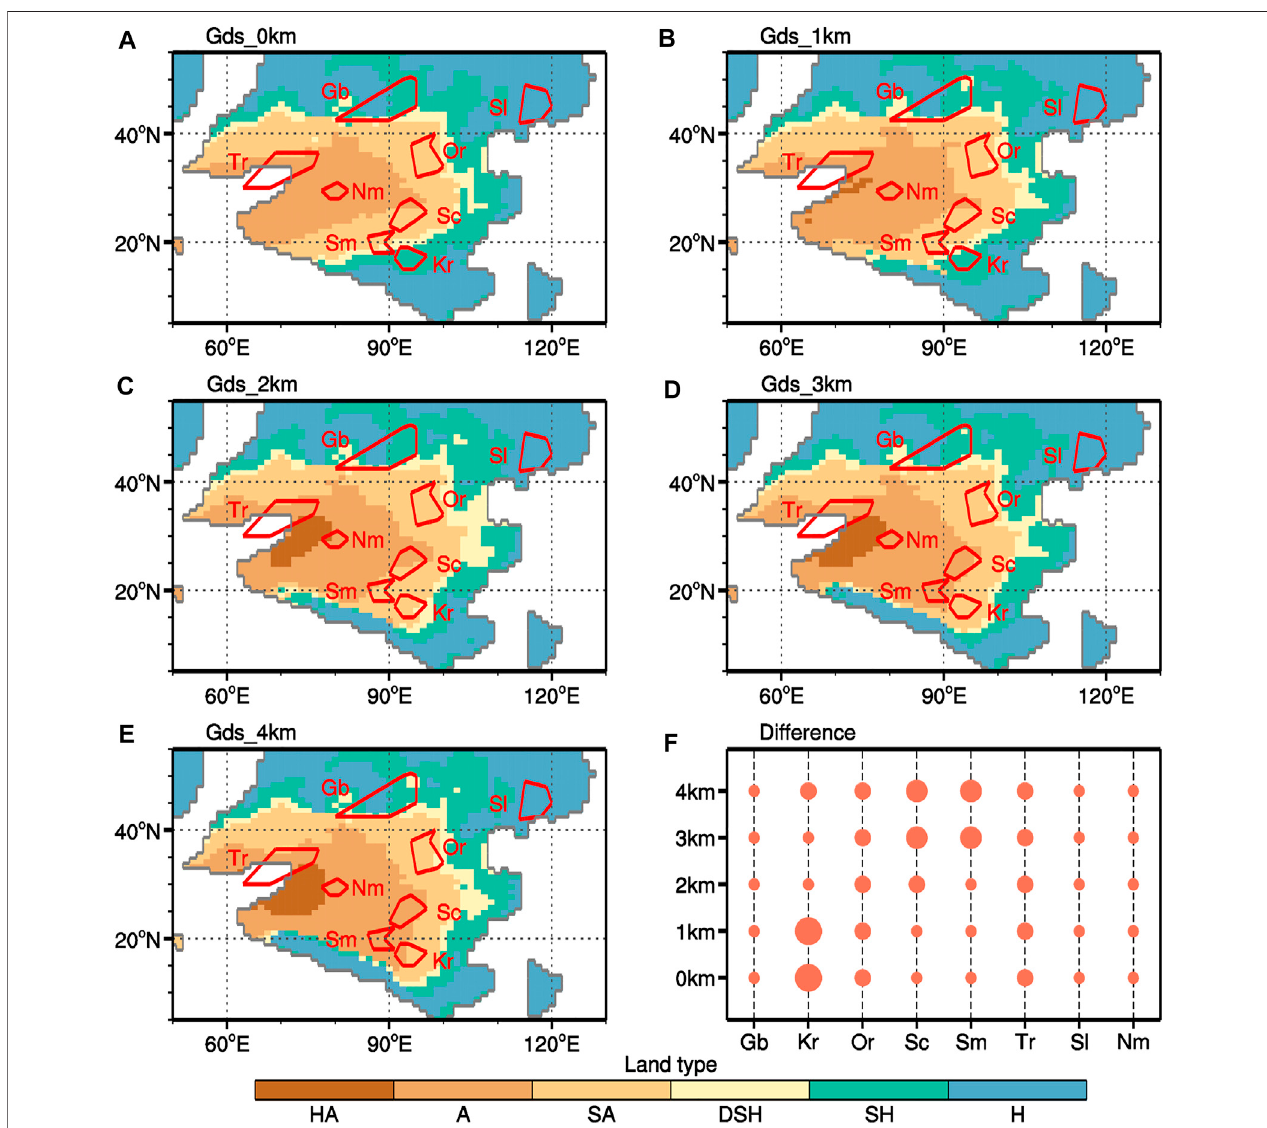
FIGURE5| LandtypesofexperimentsGds_0 km (A) ,Gds_1 km (B) ,Gds_2 km (C) ,Gds_3 km (D) ,Gds_4 km (E) ,respectively,anddifferencebetweenmodeling results and geological reconstruction ineach Basin (F) .Forthelandtypes in (A – E) ,Hisforthehumid type, SHforthesemi-humid type, DSH fordrysub-humidtype, SA for the semi-arid type, A for the arid type, and HA for the hyper-arid type, respectively; And each irregular polygon in A-E represents a basin (DeCelles et al., 2007; Hasegawaetal.,2012;Wangetal.,2013),andabbreviatedbasinnamesareasfollows:Gb (cid:2) Gobi,Tr (cid:2) Tarim,Or (cid:2) Ordos,Sc (cid:2) Sichuan,Sm (cid:2) Simao,Kr (cid:2) Khorat, Sl (cid:2) Songliao, Nm (cid:2)